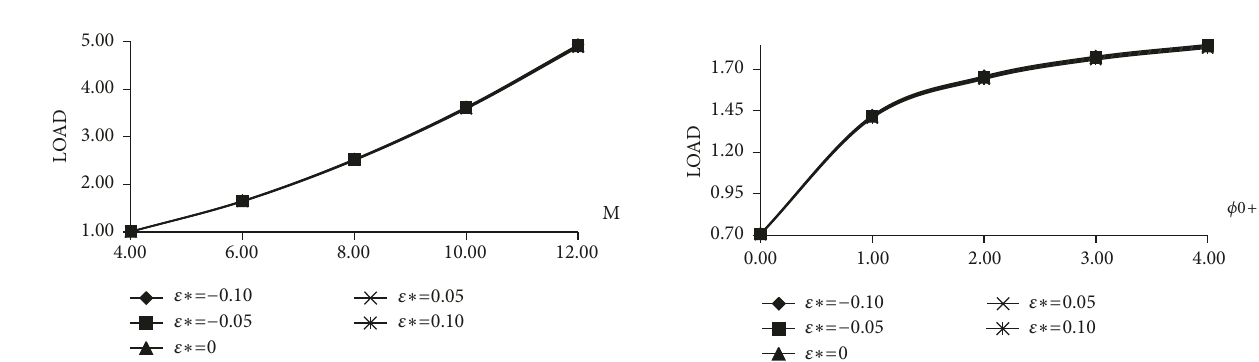
Figure 5: Variation of load carrying capacity with respect to M and 𝜀 ∗ .